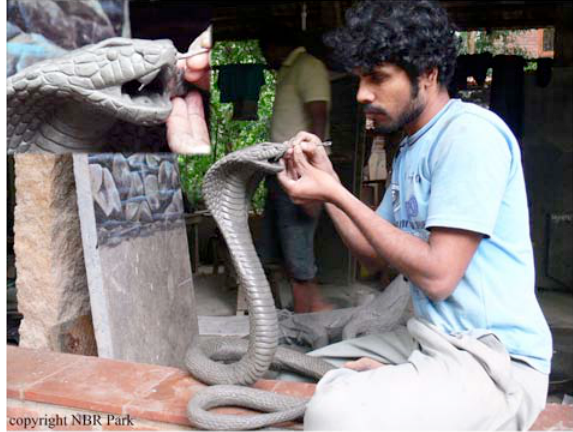
Image 13. An artist working on a yet to be finished life sized ferro cement model of an Indian Cobra Naja naja . Detail is crucial to such efforts – every scale has to be faithfully represented, including the small cunate scale among the infralabials. Commissioned by Nilgiri Biosphere Reserve Park, Anaikatti.